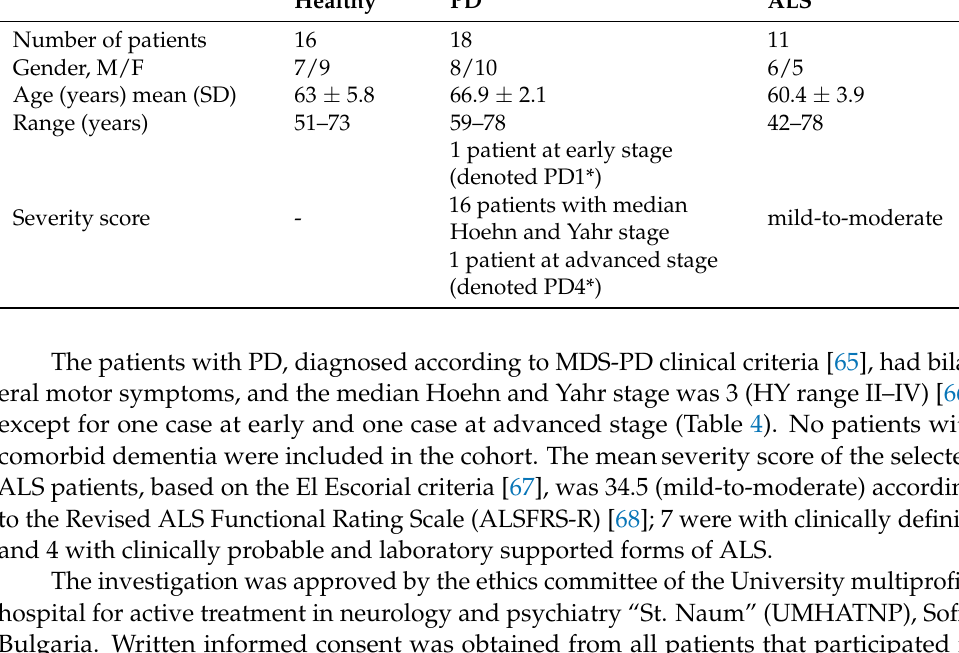
Table 4. Characteristics of patients and healthy controls. Healthy PD ALS Number of patients